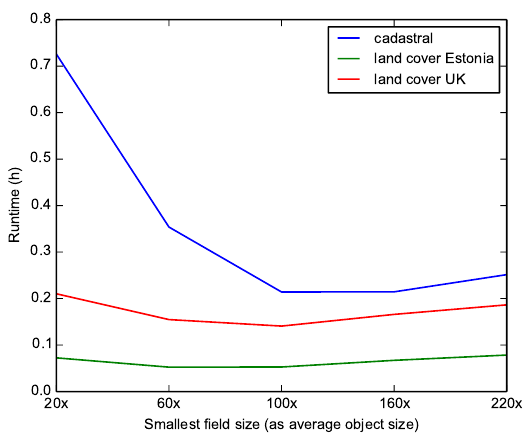
Figure 6: Processing time needed versus field size (smallest fields). Note that the smallest field size was determined based on the average feature size in the dataset.